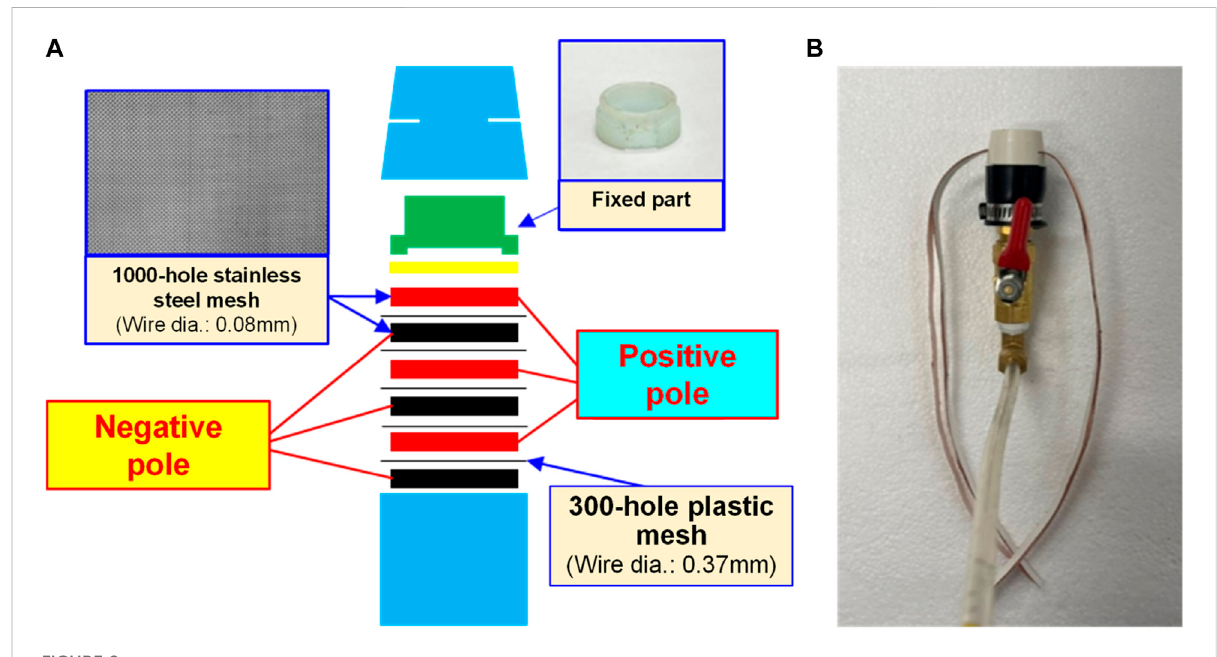
FIGURE 2 Electrolytic module (A) schematic diagram and (B) physical picture.